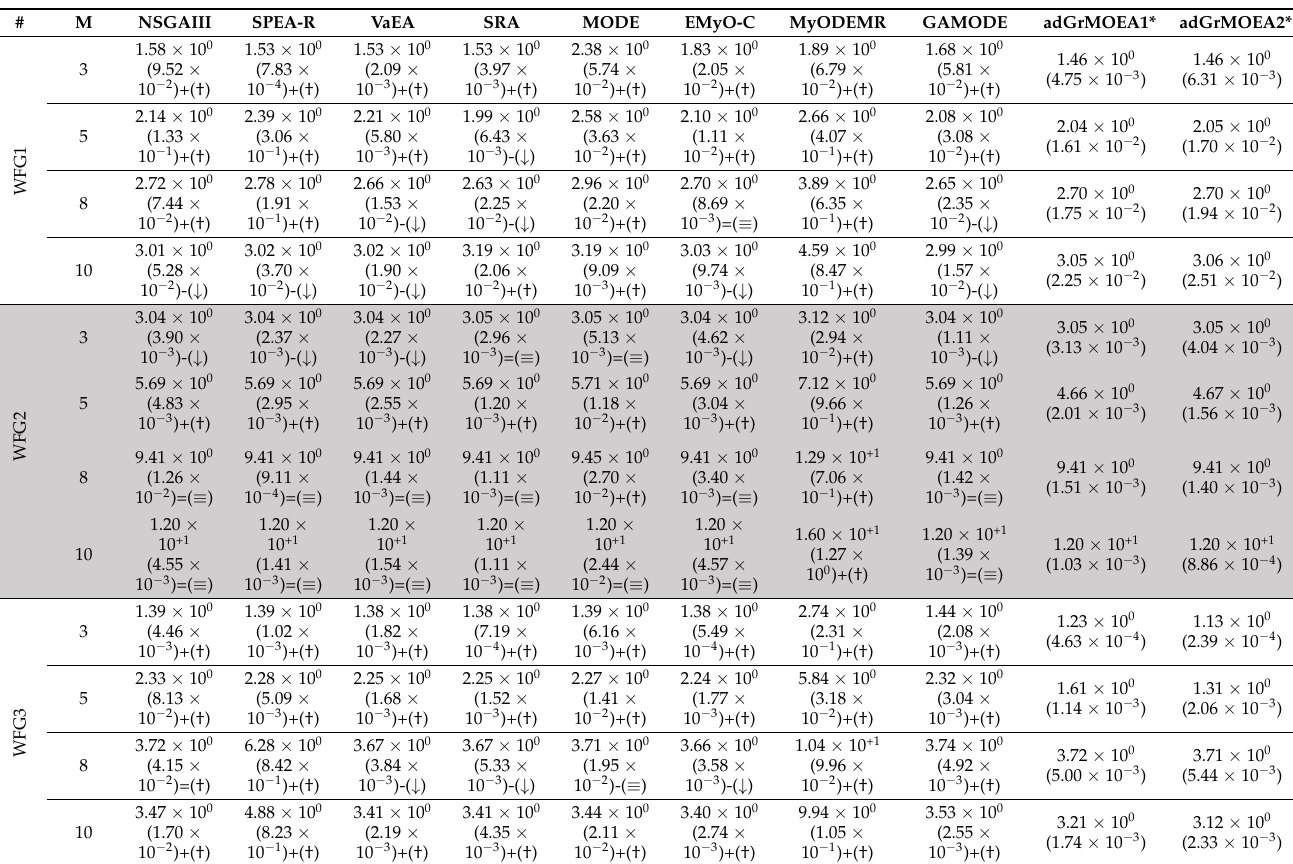
Table A6. Mean and standard deviation values of IGD results of proposed method with state of art algorithms on WFG